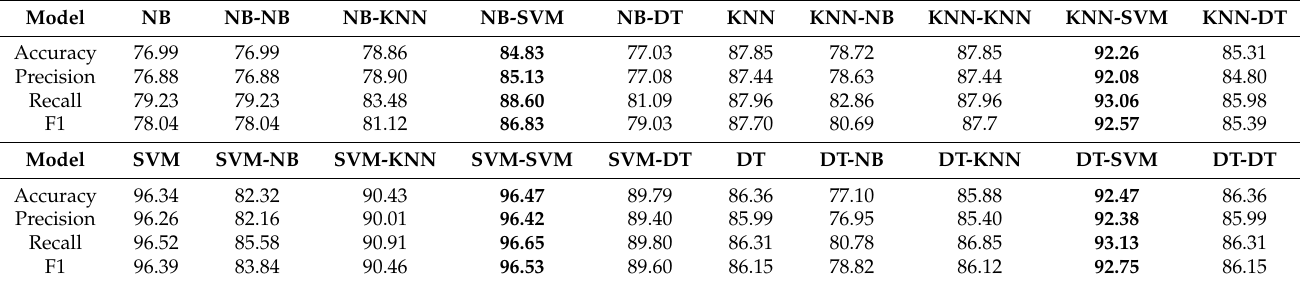
Table 5. Recognition performance on the UCI-HAR dataset.